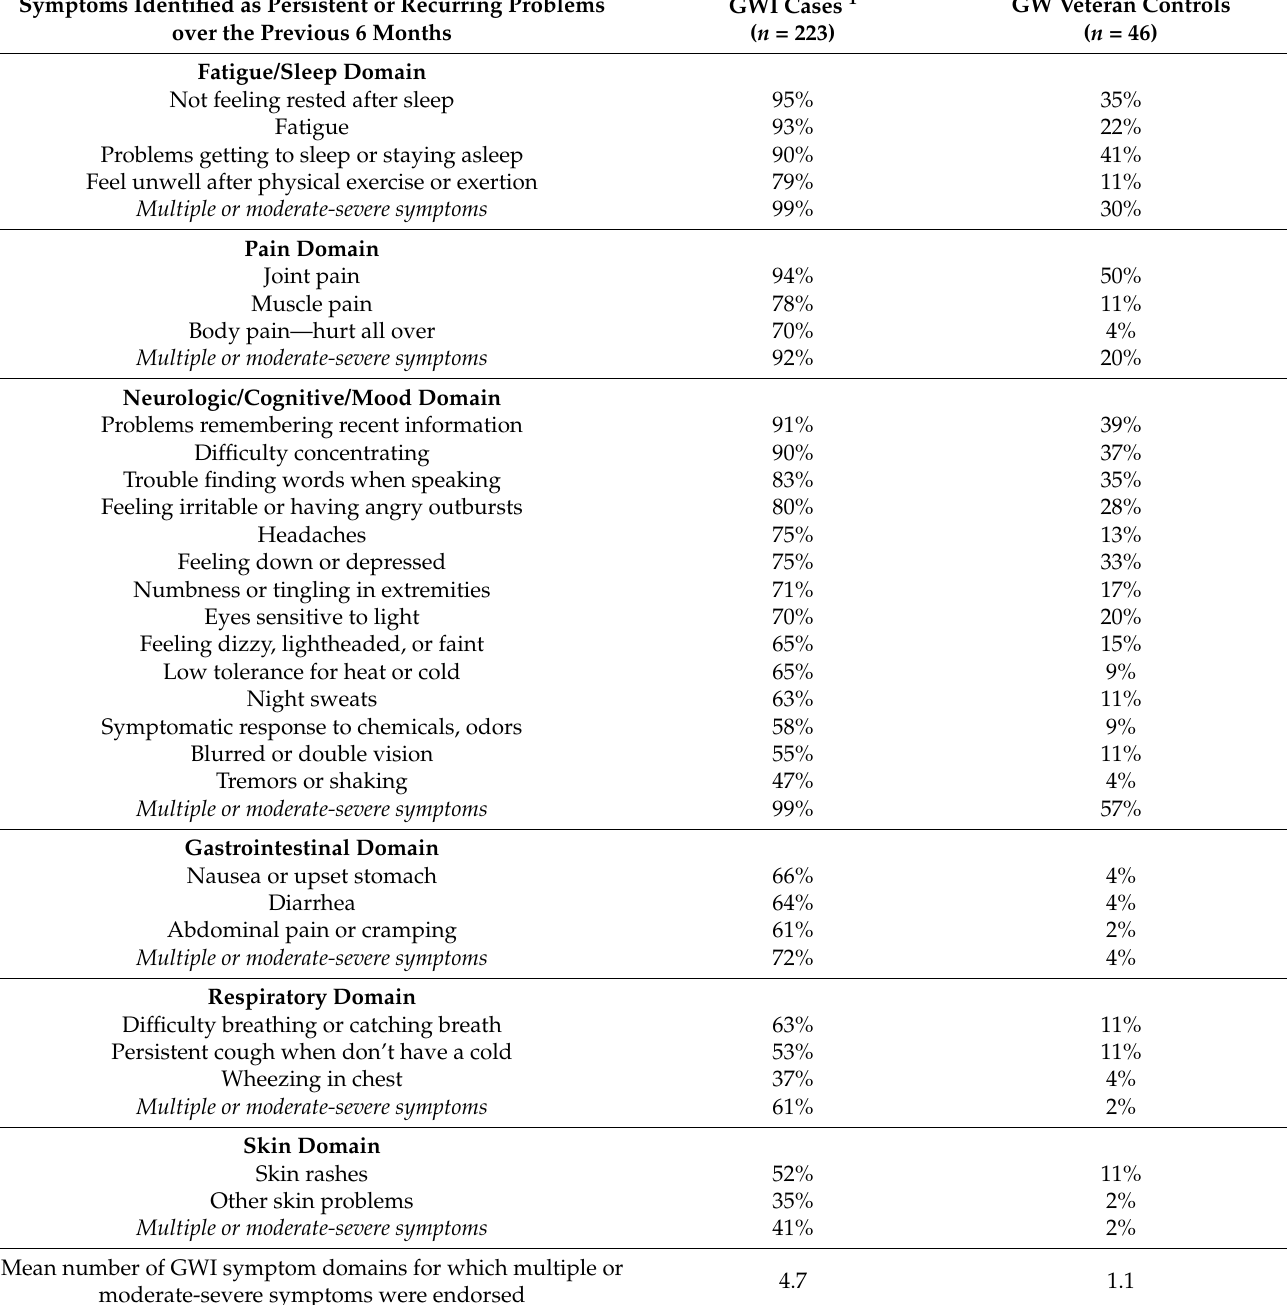
Table 3. Proportion of GWI cases and controls endorsing chronic